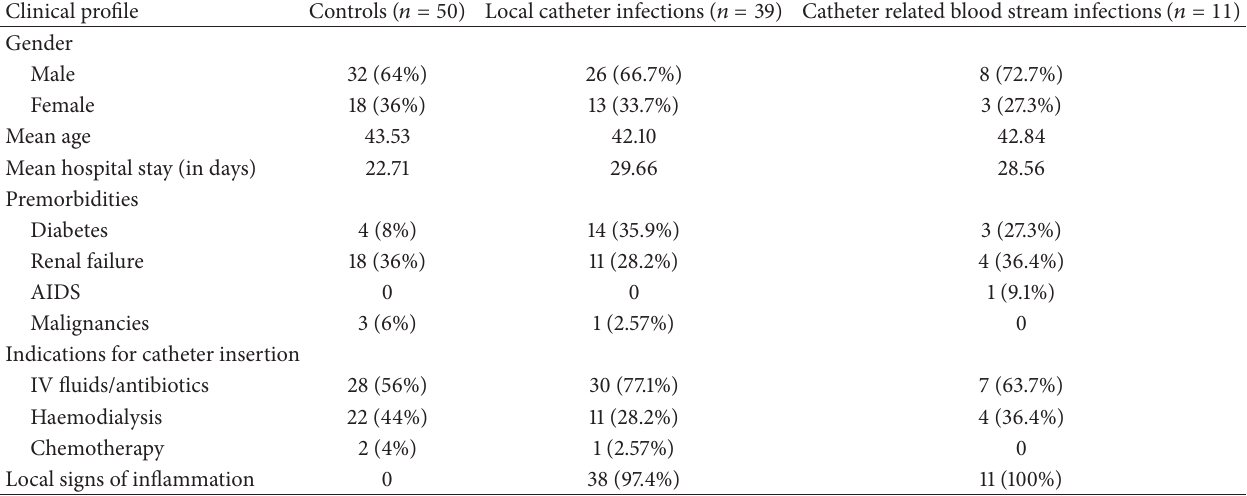
Table 1: Clinical profile of study population.